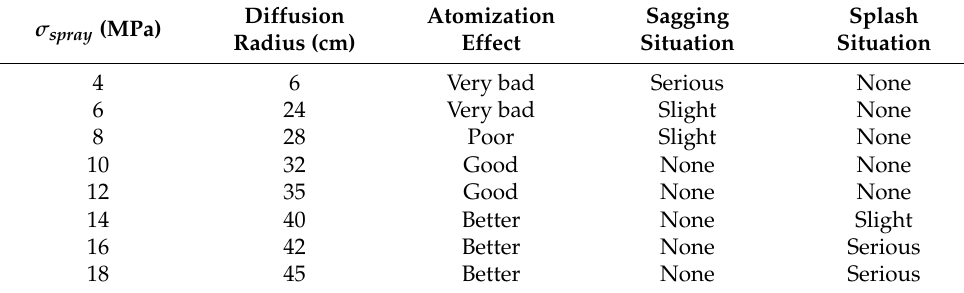
Table 3. Relationship between pressure value of spraying and spraying effect.